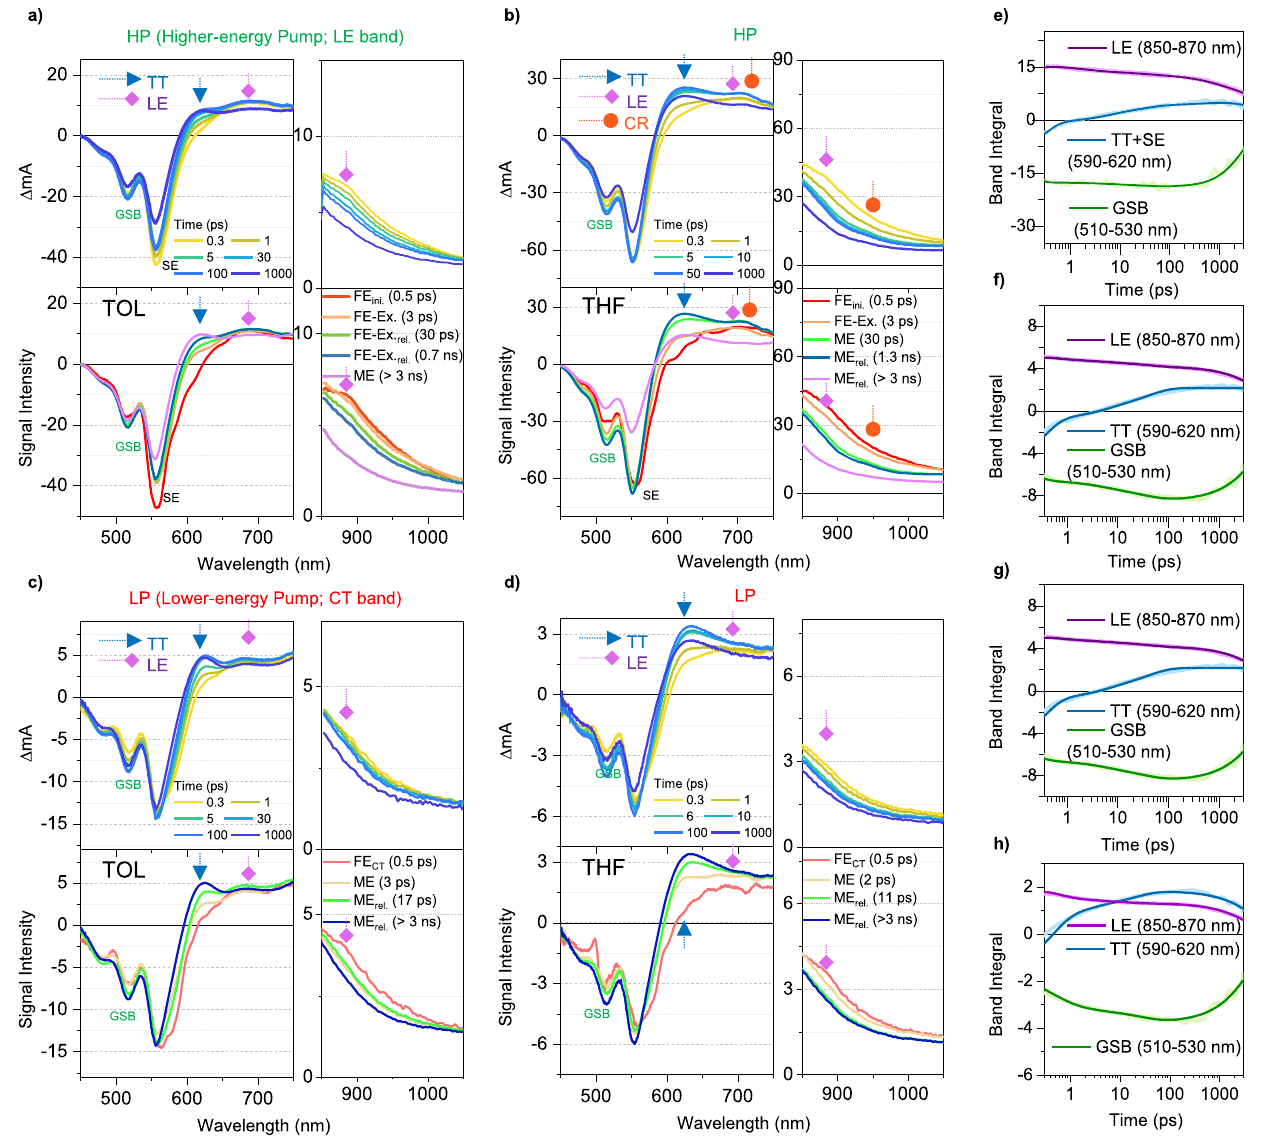
Fig. 3 | The fs-transient absorption (TA) measurements of Tris-PBI upon pho- toexcitation at higher energy (HP, 550nm) and lower energy (LP, 600nm). a , b The representative spectra (top panel) and EAS (bottom panel) of Tris-PBI in TOL( a )andTHF( b )byHP.Therespectivearrowsindicatethegroundstatebleach (GSB),locallyexcited(LE;diamond),charge-resonance(CR;circle),andtripletpair (TT; triangle). c , d The representative spectra (top panel) and EAS (bottom panel)